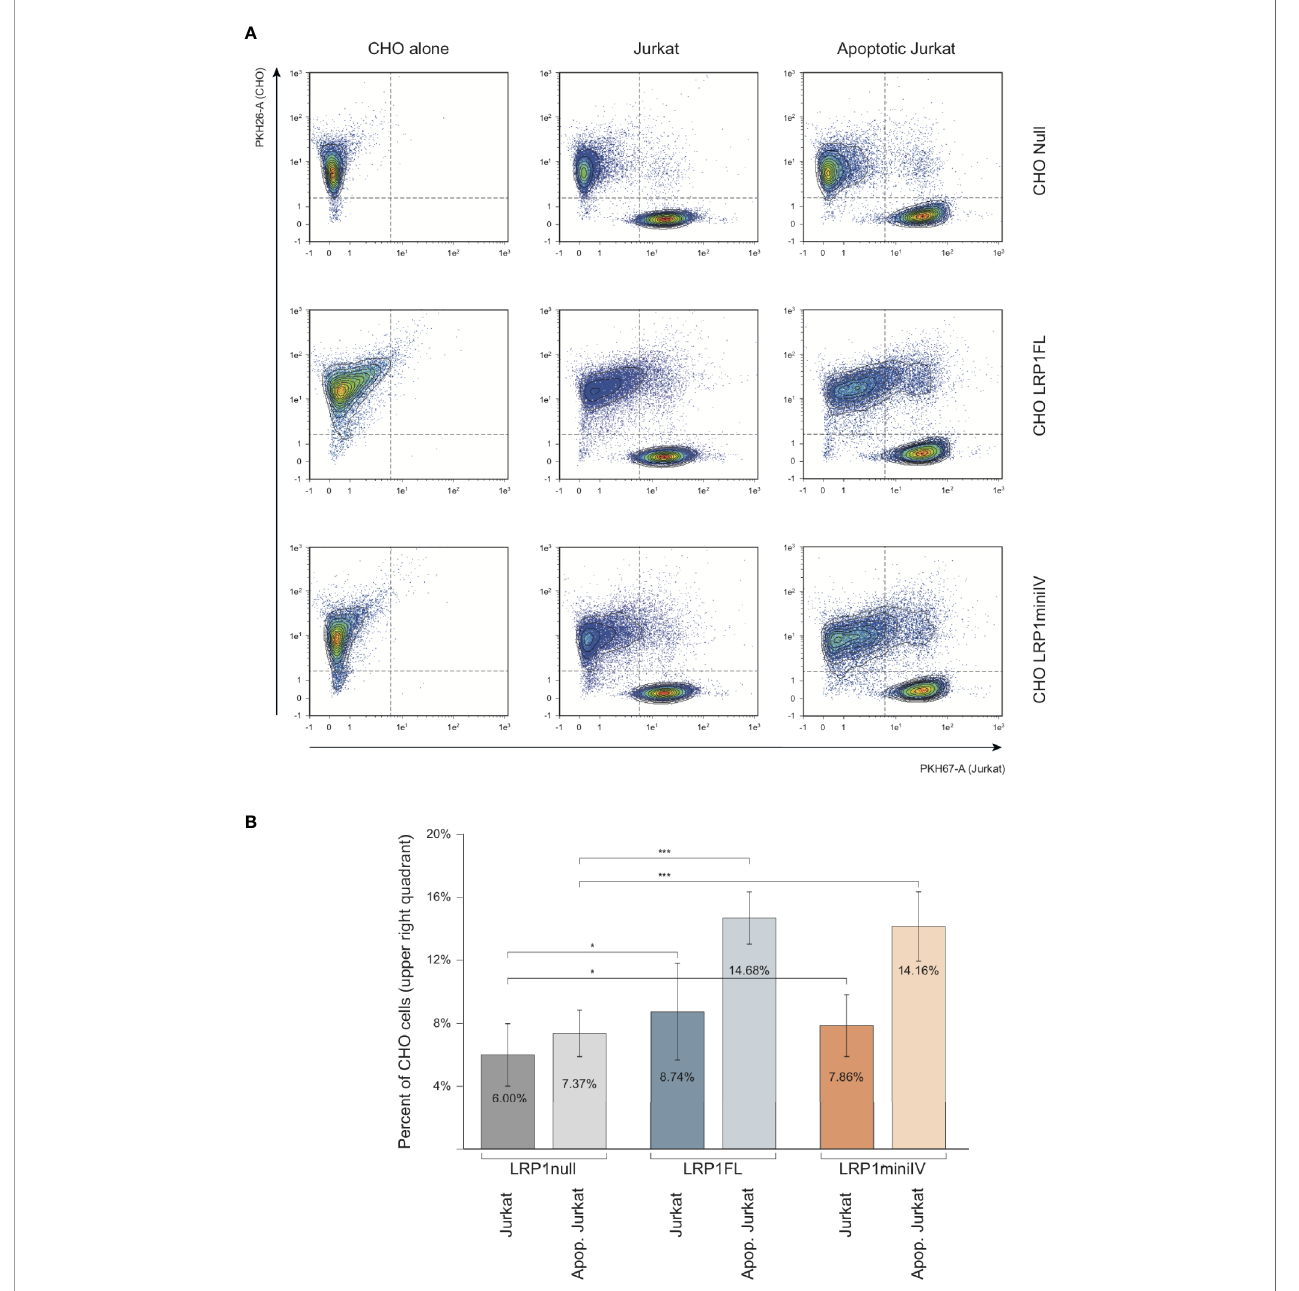
FIGURE 9 | Flow cytometry analysis of the interaction of Jurkat apoptotic cells with LRP1 full-length and mini IV CHO cells. (A) Dot plots of the analysis of PKH26 fl uorescent CHO cells (red, Y4-A channel) decorated by PKH67 fl uorescent Jurkat cells (green, B1-A channel). Decoration ef fi ciency is calculated in the upper quadrant of the region drawn, as the percentage of PKH26 positive events (B) Histograms obtained from 13 independent experiments. Student T test relevance is shown above the histograms. *** Student bilateral unpaired <1 × 10 − 2 , * Student bilateral unpaired <2 × 10 − 1